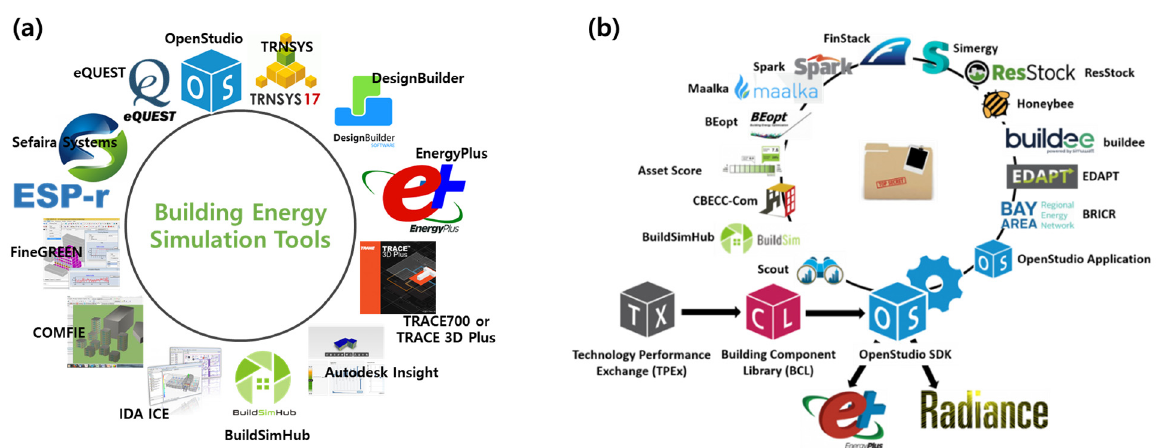
Figure 2. ( a ) Building energy modeling tools found in BEST Directory [31] and ( b ) public and private sector tools and services via the OpenStudio Platform that EnergyPlus directly supports [32].